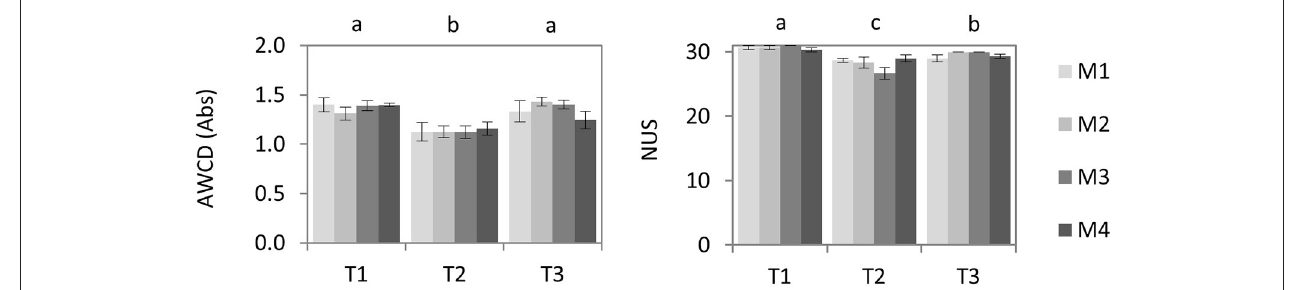
FIGURE 5 | Mean values and standard errors of average well color development (AWCD) and number of used substrates (NUS) in Biolog Ecoplates TM after 12 days incubation at 30 ◦ C. Values of each biodisinfestation treatment (M1, M2, M3, M4) at three different times: T1 (pre-treatment), T2 (post-treatment) and T3 (post-crop after treatment). No statistical differences ( P ≤ 0.05) were obtained among treatments. Letters indicate the significant differences among times according to Tukey HSD test ( P ≤